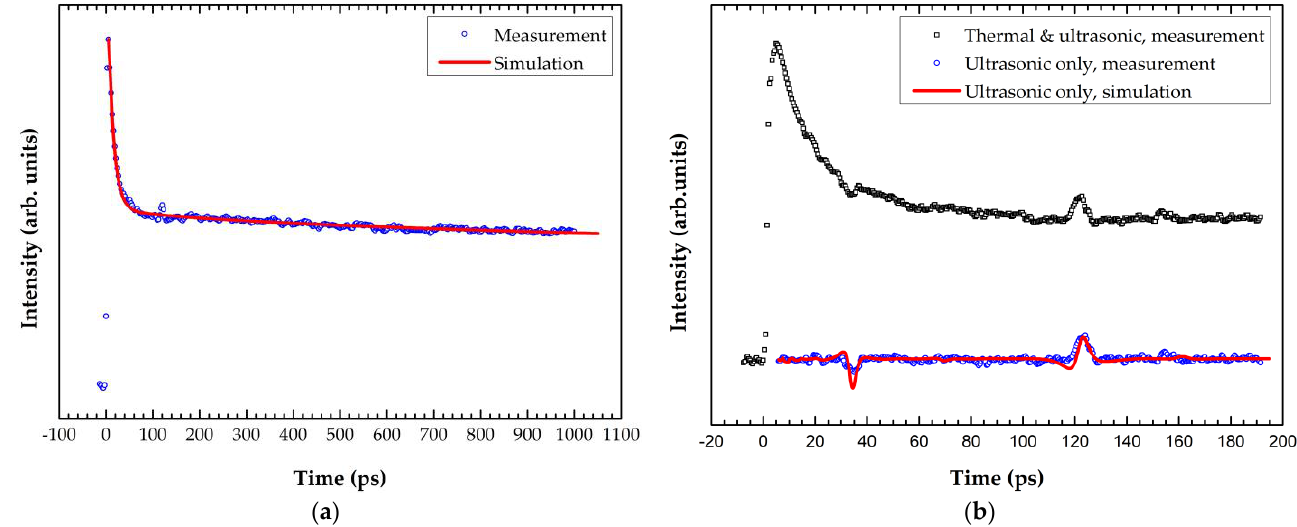
Figure 6. Laser-ultrasonic measurement and curve-fitting results for the 100 nm a-SiC: ( a ) κ a-SiC = 1.0 ± 0.2 W/(m·K) and G Al/a-SiC = 3.7 ± 1.4 m 2 ·K/GW were obtained from the thermal response; ( b ) E a-SiC = 67 ± 3 GPa was obtained from the ultrasonic response.